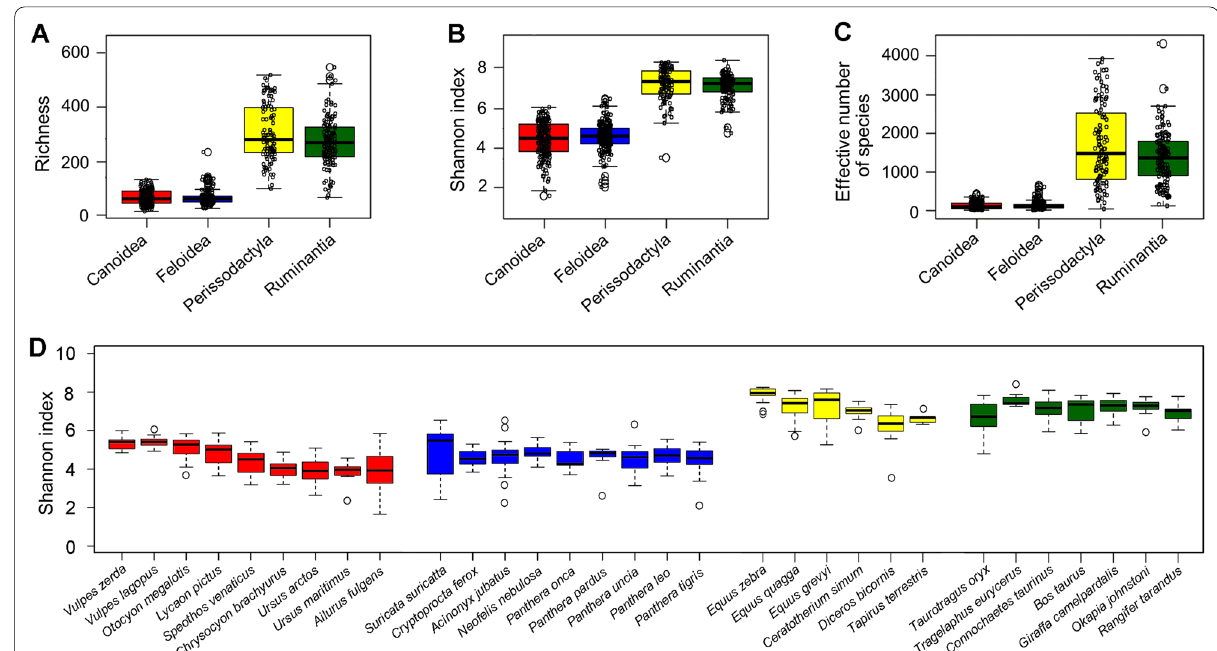
Fig. 2 Alpha diversity of carnivores (Canoidea and Feloidea) and herbivores (Ruminantia and Perissodactyla) measured as species richness ( A ), Shannon index ( B ) and effective number of species ( C ). Part ( D ) shows the Shannon index for all analyzed species. Kruskal–Wallis p < 0.01, df Dunn Test with Bonferroni correction p < 0.001 for all diversity indices Statistical results for pairwise comparisons are presented in an Additional file